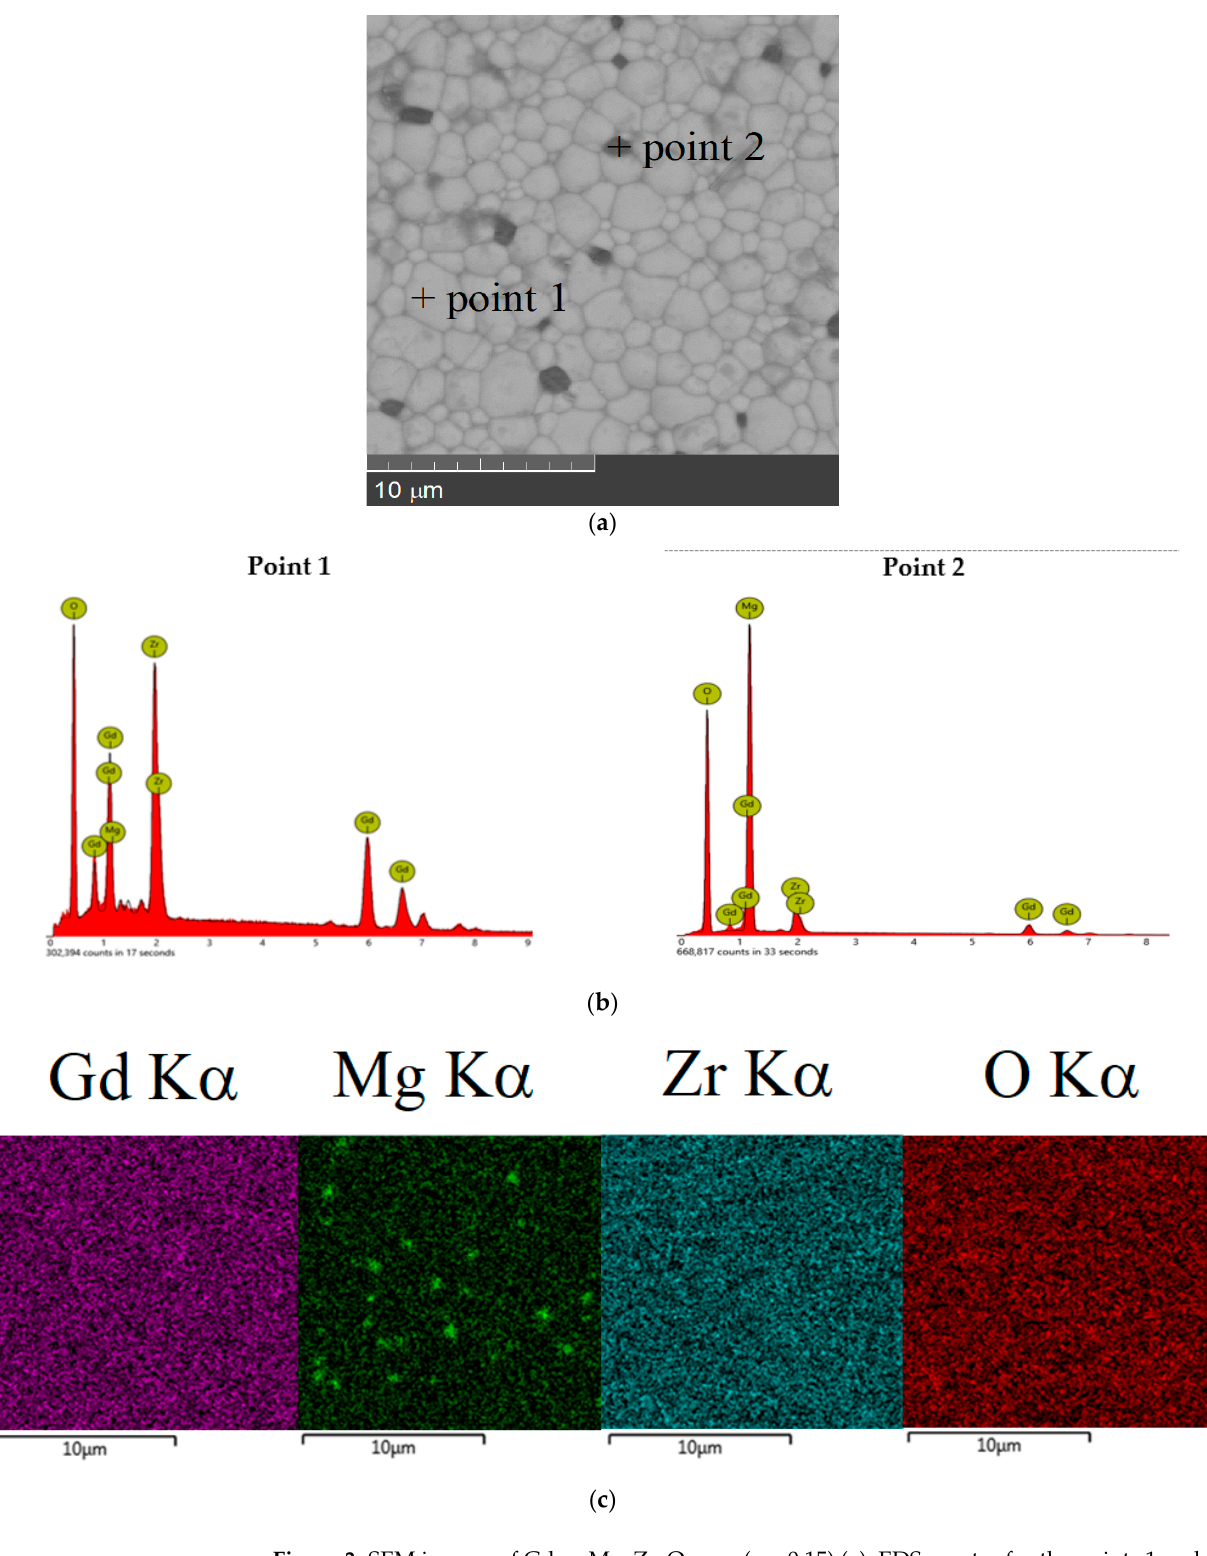
Figure 3. SEM images of Gd 2 − x Mg x Zr 2 O 7 − x/2 (x = 0.15) ( a ), EDS spectra for the points 1 and 2 ( b ); gadolinium, magnesium, zirconium, and oxygen distribution for Gd 2 − x Mg x Zr 2 O 7 − x/2 (x = 0.15) ( c ).